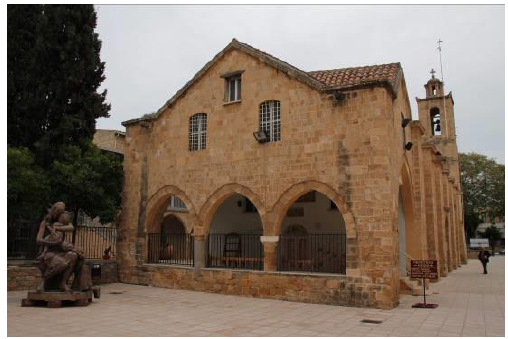
Figure 1. Main façade of Saint John Cathedral in Nicosia